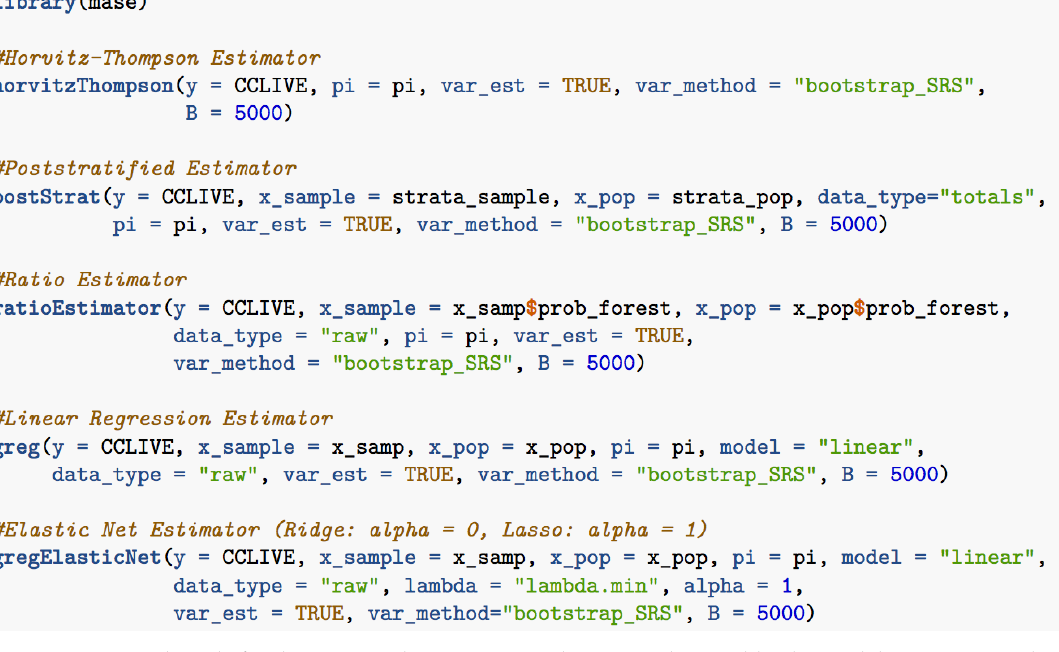
Figure 6. Sample code for the mase package in R. For a binary study variable, the model argument can be changed to